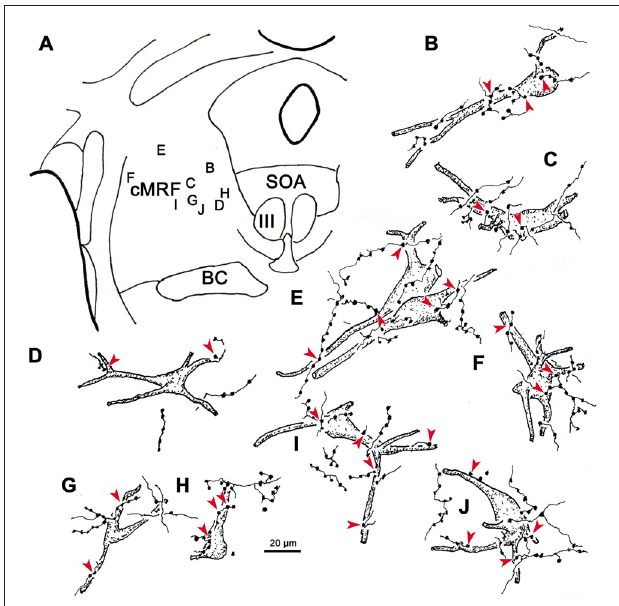
FIGURE 12 | The relationship between tectal inputs and reticuloreticular neurons in the cMRF. Drawings reveal the presence of close associations (arrowheads) between BDA labeled tectoreticular terminals and reticuloreticular cells (B–J) labeled from a PRF injection of WGA-HRP. The location of the example cells within the cMRF is shown in (A) . While a number of close associations are present, the labeled axons rarely (E,H) follow the contours of the cell, and the number of contacts varied. FIGURE 13 | Pattern of contacts between tectoreticular terminals and